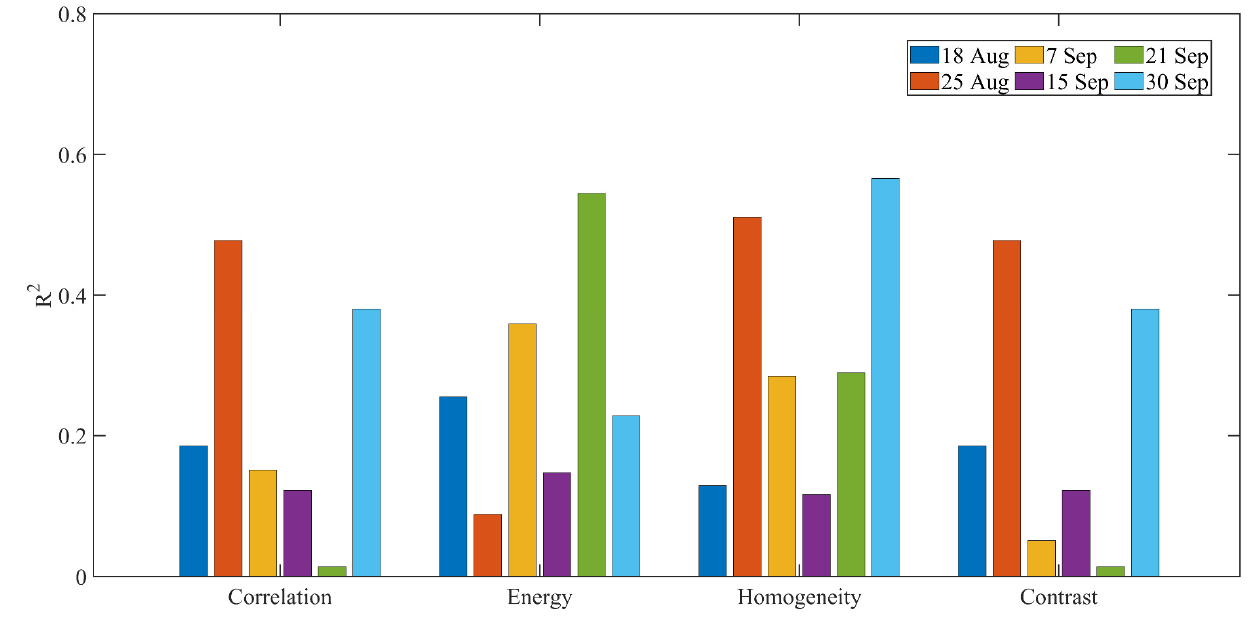
Figure 7. The R 2 of the regression between textural indices and SPAD values at each growth stage of maize. The results of SRM for identifying the optimal combination of SIs and TIs for predicting SPAD values at each growth stage of maize are shown in Table